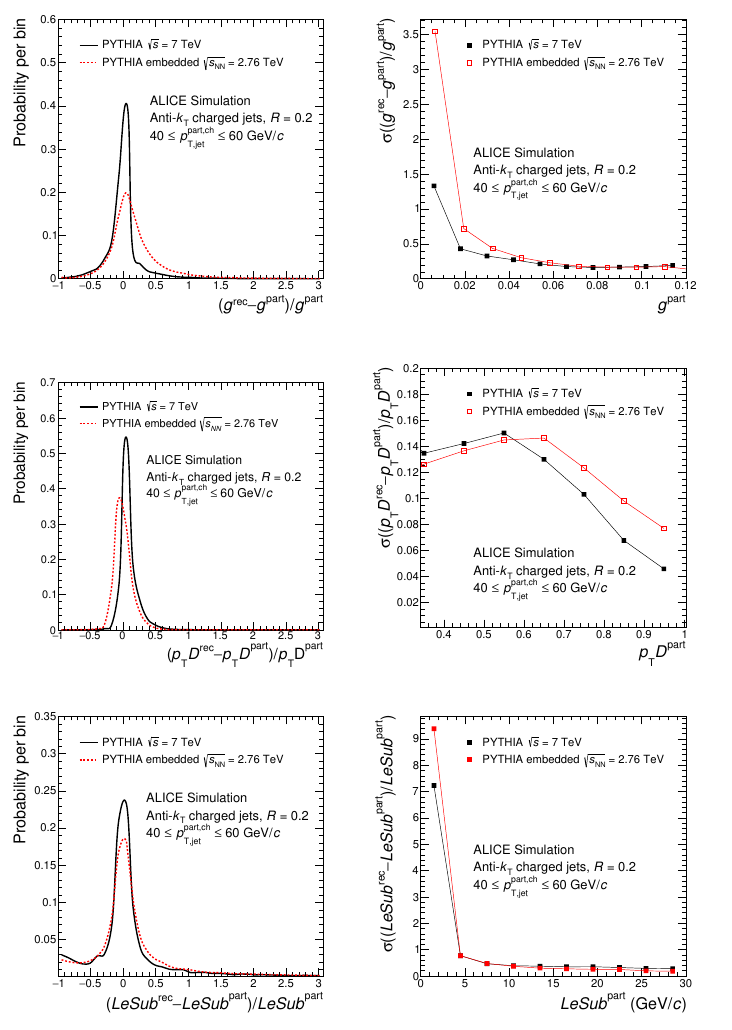
Figure 4 . Left plots show the distributions of residuals for the set of three jet shapes in a given interval of p part ; ch 40{60 GeV/ c using the PYTHIA and PYTHIA embedded simulations. Right T ; jet plots show the width (quanti(cid:12)ed as the standard deviation) of the distributions on the left as a function of the values of the shapes at particle level. The black and red curves correspond to pp and Pb-Pb simulations, respectively. The line connecting the points on the right is drawn to guide the